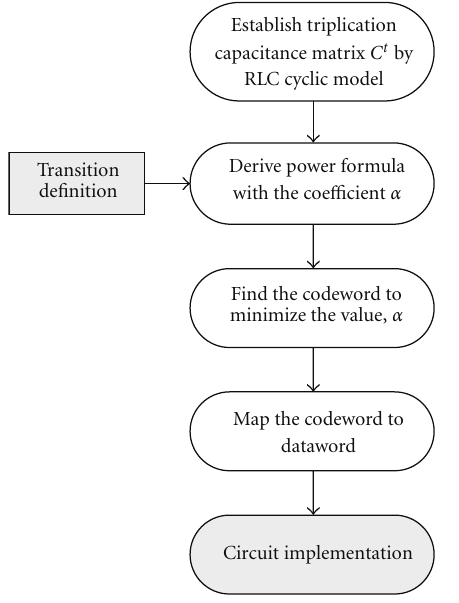
Figure 7: The design flow of the green bus coding stage.